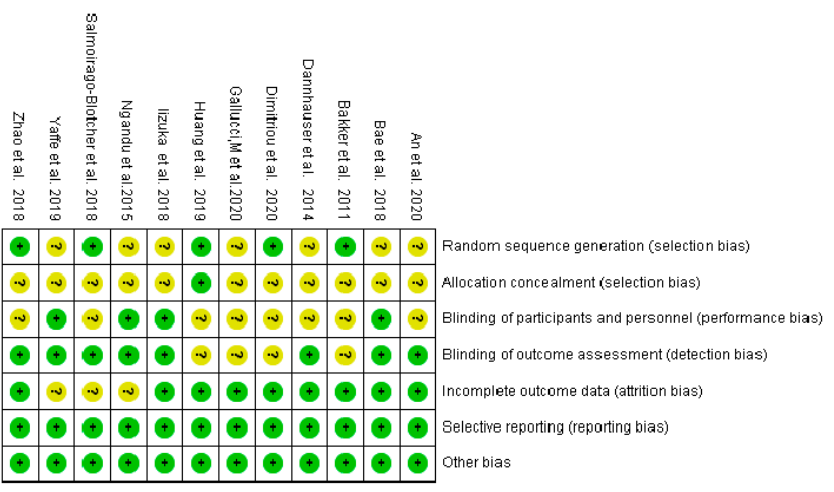
Figure 2. Evaluation of bias risk [29–40].